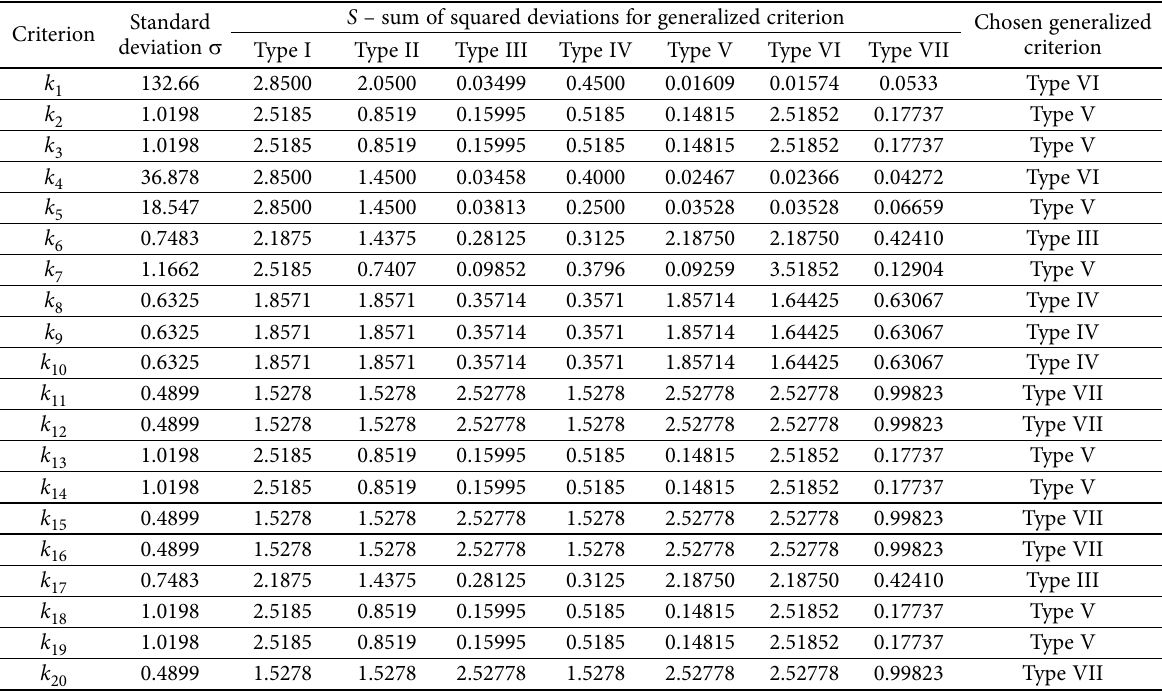
Table 3. Standard deviation and chosen generalized criterion